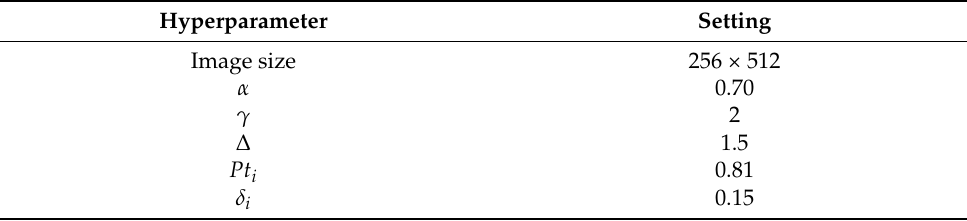
Table 2. Parameter settings.